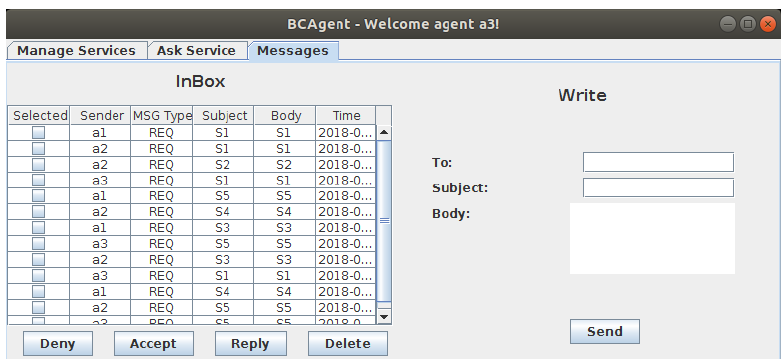
Figure 7. View to search and ask for a service.